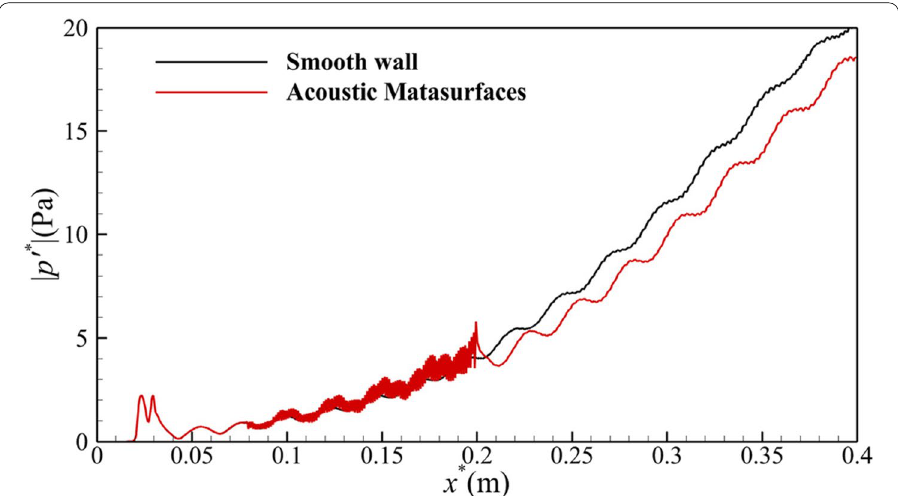
Fig. 13 Comparisons of fluctuating pressure amplitude distributions along the hot wall with a temperature of 400 K and disturbance frequency of 80